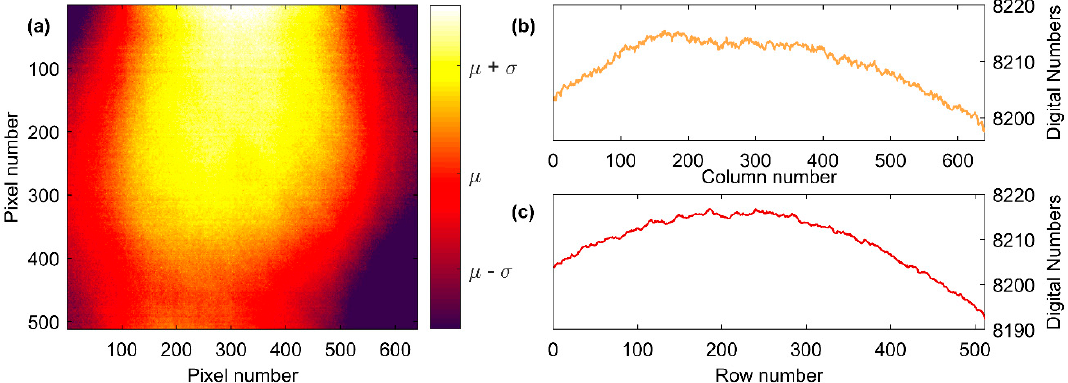
Figure 6. Analysis of the vignetting effect in images of ( a ) a stable blackbody, with mean image DN = 9167 ( σ = 8.26 DN); and ( b – c ) images taken of a mire surface during Flight A. ( b ) shows column mean DN while ( c ) shows row mean DN (see Section 2.2.3. for details). Row number 0 corresponds to the top of the sensor and column number 0 to the left side of the sensor.